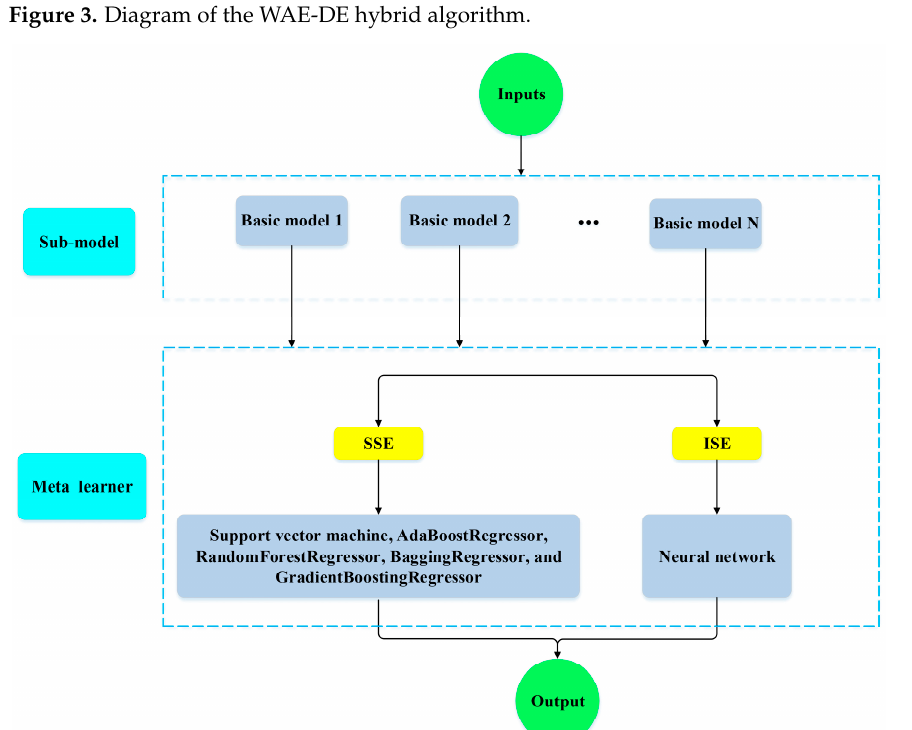
Figure 3. Diagram of the WAE-DE hybrid algorithm.